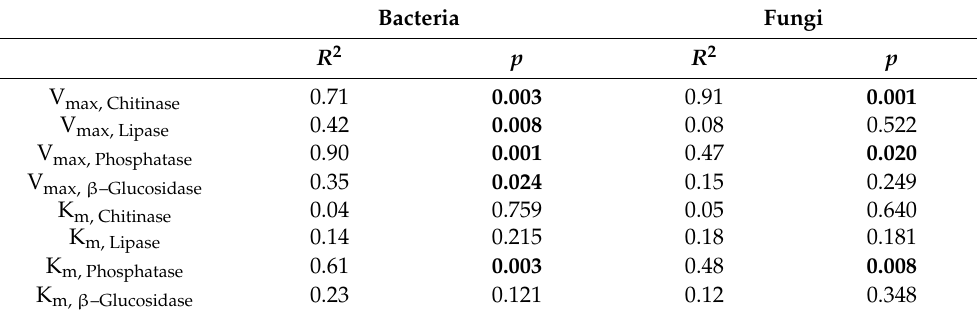
Table 2. Goodness of fit statistics ( R 2 ) of the mean of respective enzyme’s activity fitted to the non- metric multidimensional scaling (NMDS) ordination of bacterial and fungal community composition based on presence/absence data and Jaccard distance similarity of soils in all treatments. Bold letter indicates statistical significances. The abbreviations are V max : maximum rate of reaction of enzymes and K m : the concentration of substrate which permits the enzymes to achieve half of V max . Bold p values indicate statistical significances p < 0.05.